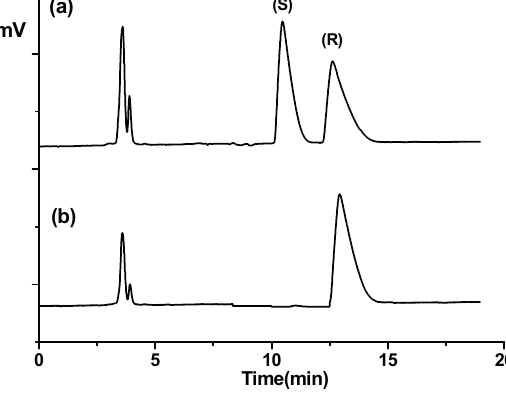
Figure 4. Comparison of the chromatograms for the resolution of ( a ) racemic fendiline and ( b ) ( R )-fendiline on CSP 1 with the use of a mobile phase consisting of methanol–acetonitrile–trifluoroacetic acid–triethylamine at a ratio of 80/20/0.1/0.5 (v/v/v/v). Flow rate: 0.5 mL/min. Detection: 254 nm UV. Temperature, 20